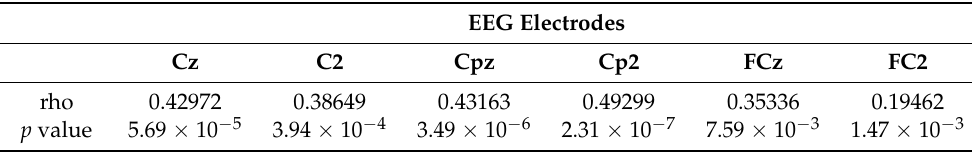
Table 4. Correlation coefficients of the alpha wave with deoxyHb in the RPMCdr cortical area during LF.